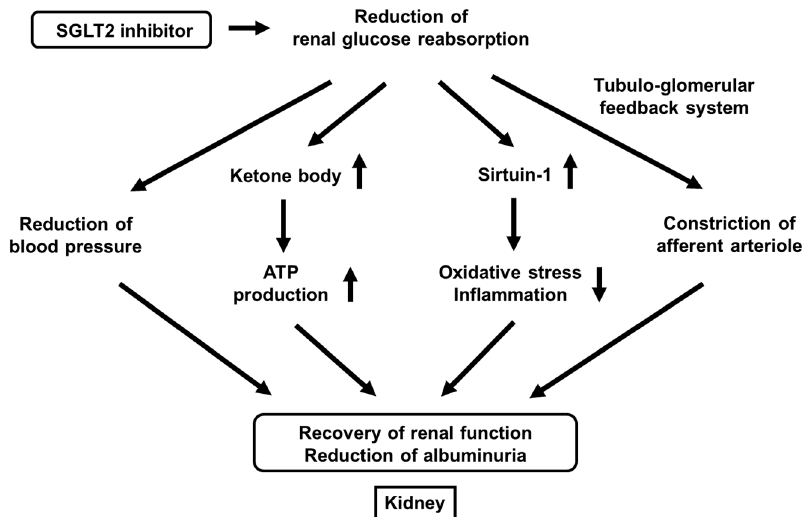
Figure 4. Favorable effects of SGLT2 inhibitors on renal function beyond their glucose-lowering effect. SGLT2 inhibitors reduce renal glucose reabsorption, which leads to the reduction of blood pressure, increase of ketone bodies, increase of sirtuin-1 expression, and constriction of afferent arteriole. All of such alterations lead to the recovery or renal function and the reduction of albuminuria.